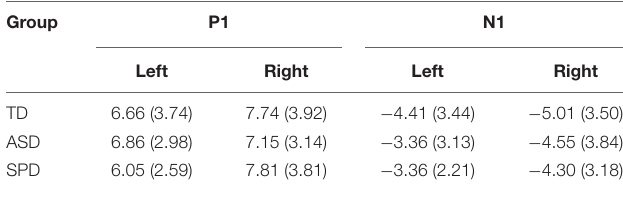
TABLE 4 | Mean (and standard deviation in parentheses) amplitude for each of the Visual Alone time windows analyzed. All units are in microvolts.